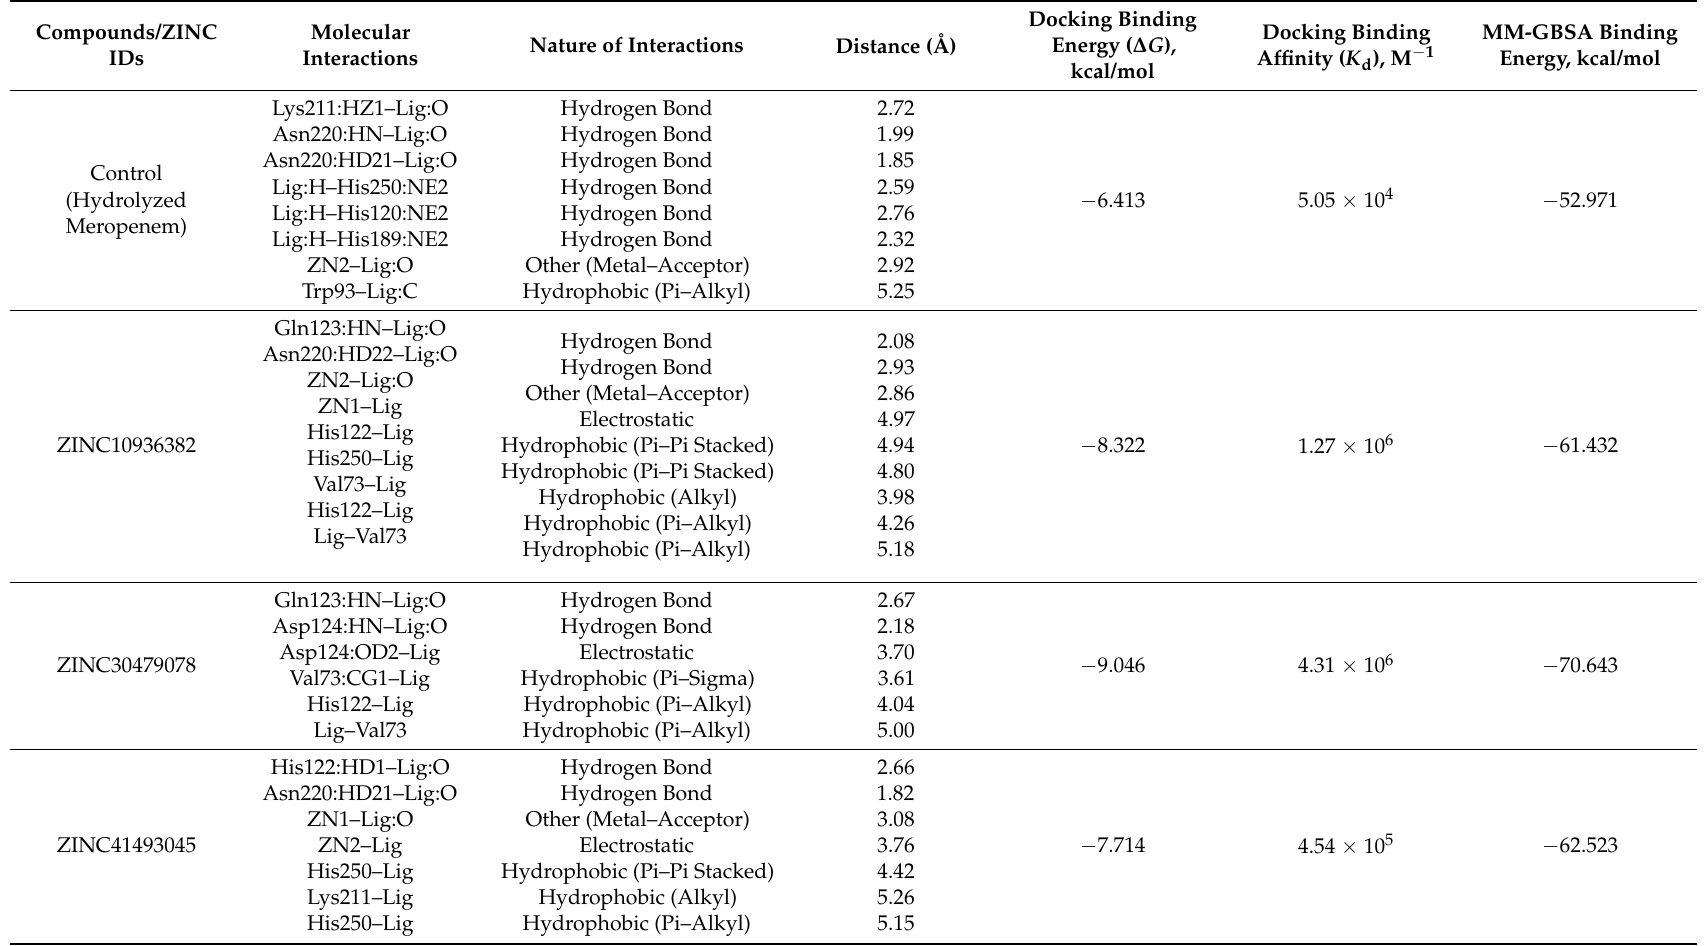
Table 4. The molecular interaction between NDM-1 and different inhibitors from the ZINC